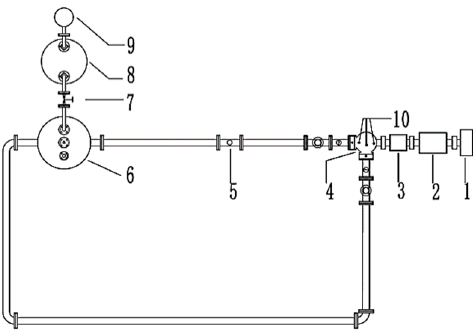
Figure 4. Test device for the coast-down transition process of the nuclear reactor coolant pump.